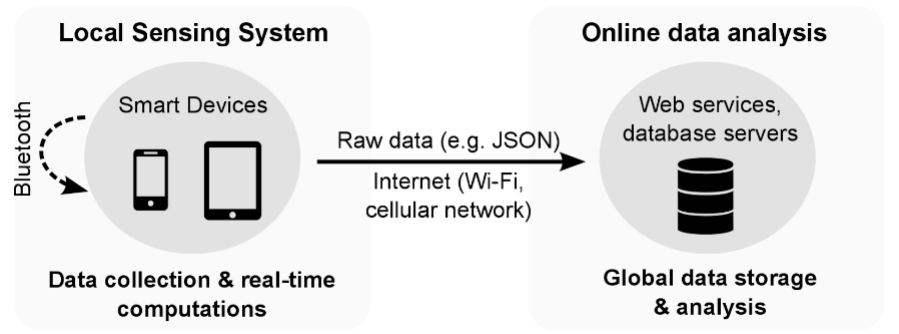
Figure 2. Overview of our sensing